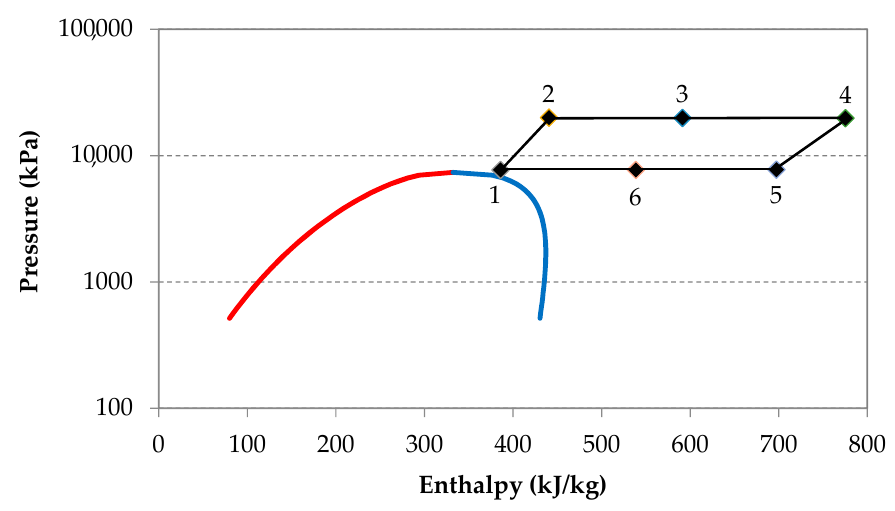
Figure 2. Temperature vs. entropy of S-CO 2 cycle.